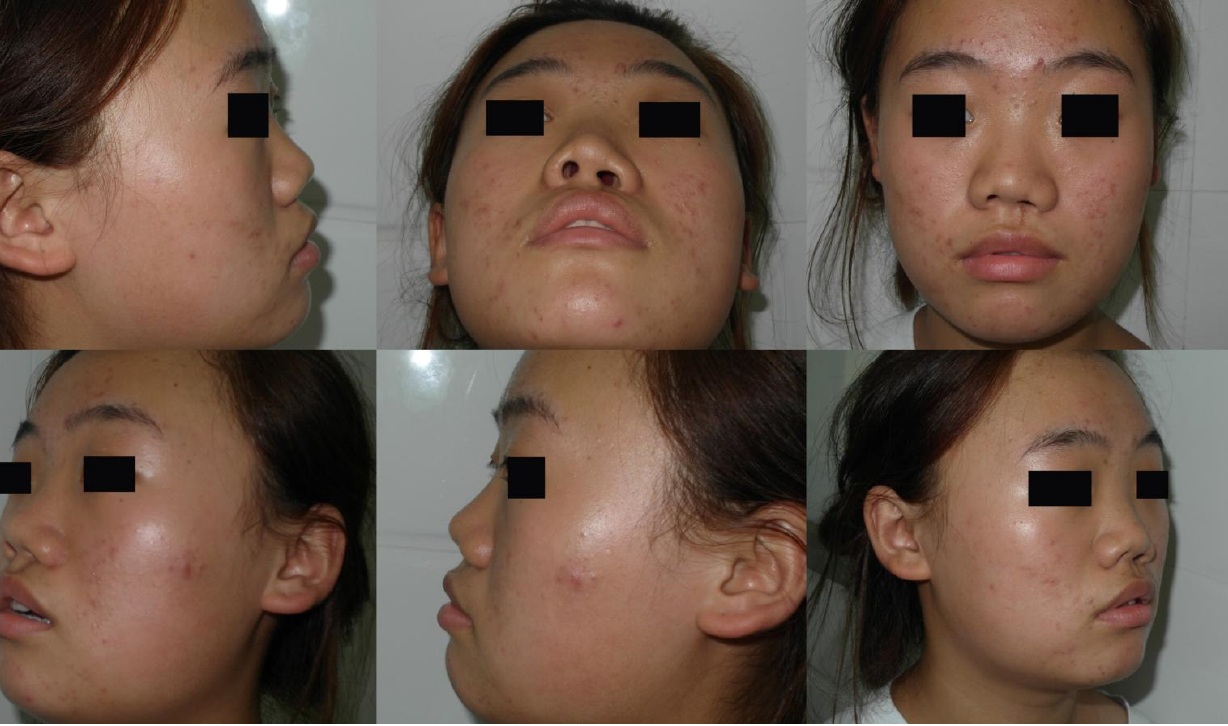
Figure 4. A 19-year-old female presented with cleft lip nasal deformity before our surgery. The photos were taken before the operation.